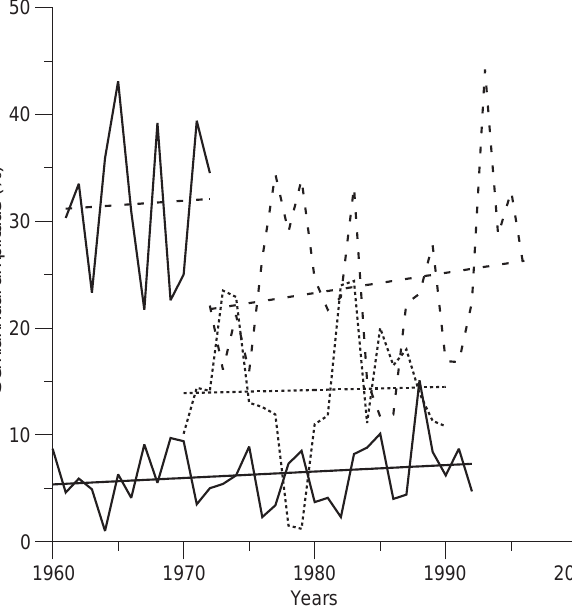
Fig. 5. Trends ((cid:139)1 r ) in the relative amplitudes of the semiannual wave ( SAW / YC ) in absorption at 2775 kHz ( solid curve , top ; k = +0.083 %/y, insignificant), 164 kHz ( solid curve , bottom ; k = +0.060 (cid:139) 0.053 %/y), 1412 kHz ( dotted curve ; k = +0.029 %/y, insignificant) and 6090 kHz ( dashed curve ; k = +0.189 (cid:139) 0.218 %/y); k – slopes of curves